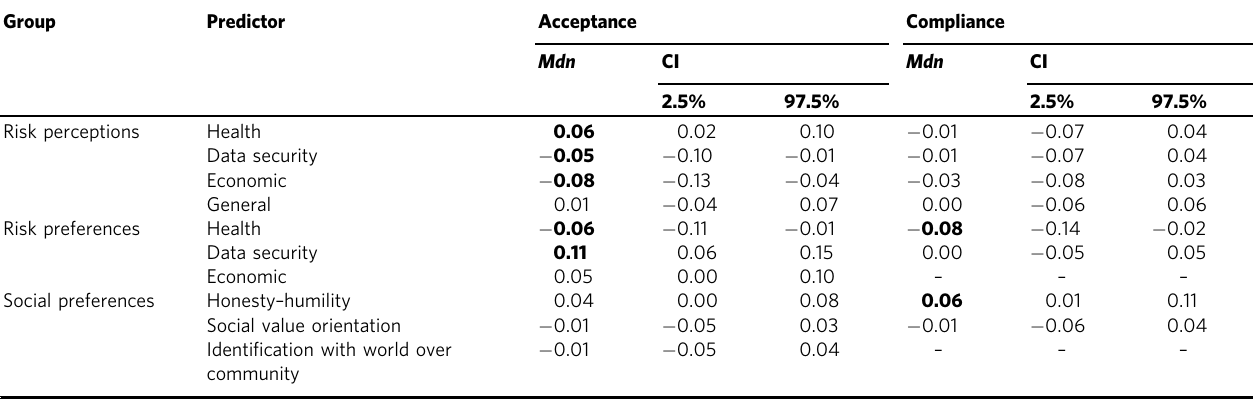
Table 1 Results of the Bayesian regression: effects on the acceptance of and compliance with digital contact-tracing applications. Group